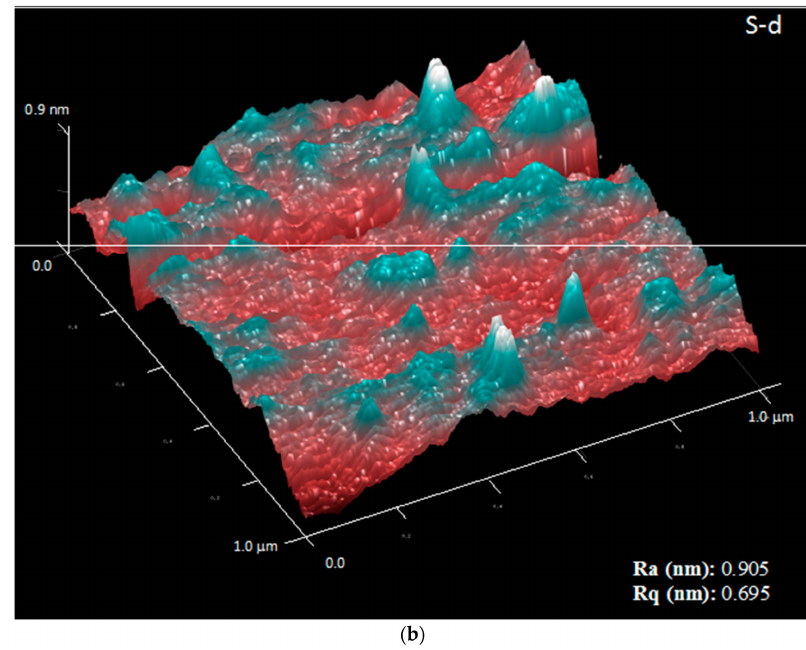
Figure 8. AFM images with scan area taken on the SiOx-coated side of S-0 ( a ) and S-d ( b ) films, and corresponding values of arithmetic average roughness (Ra) and root-mean square roughness (Rq).